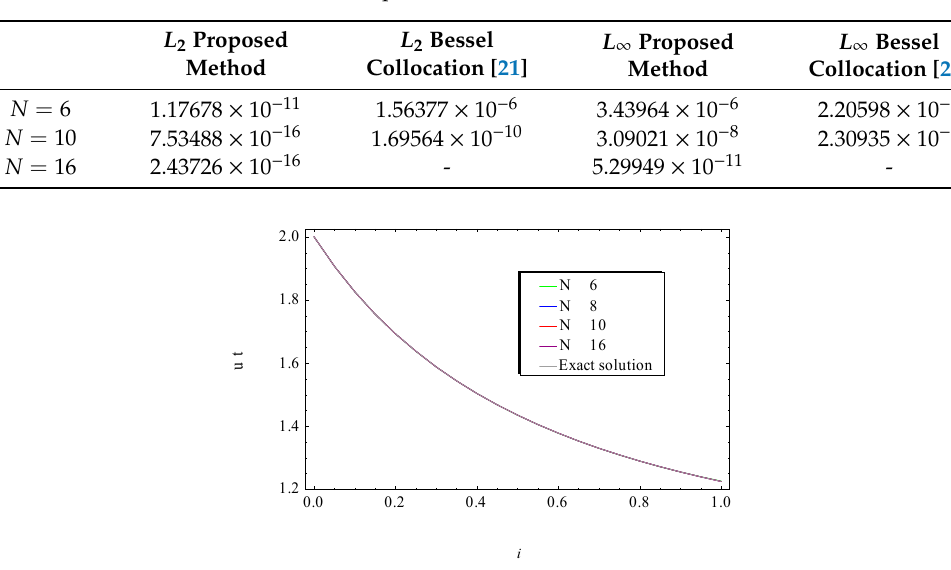
Figure 1. Approximate solution for RC collocation method at different N values.